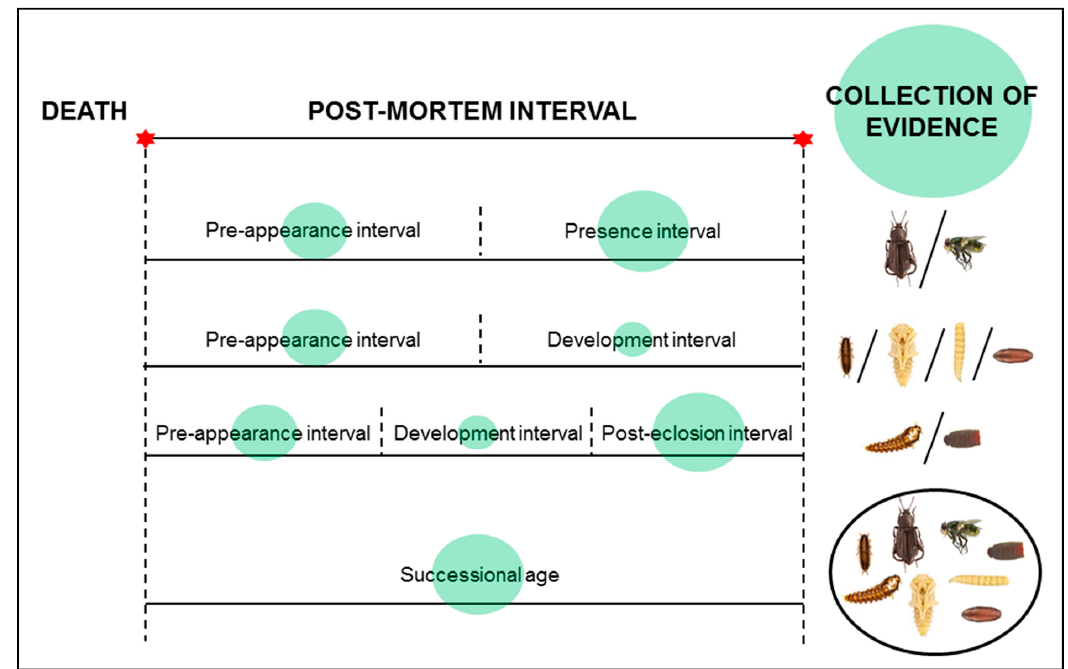
Figure 1. Sources of inaccuracy in the estimation of the post-mortem interval (PMI) based on insect evidence. Green circles represent the sources, their size represents importance of the sources. Pictures of insects were made by Anna M ą dra-Bielewicz (Pozna ń , Poland).